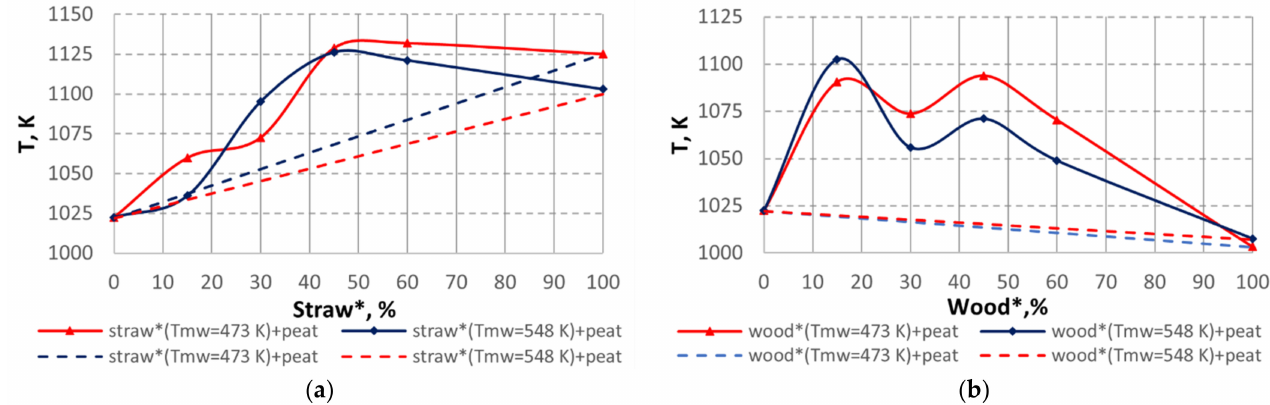
Figure 4. Effect of changes (variations) in pre-treatment temperature and composition of selectively pre-treated wheat straw* ( a ) and wood* ( b ) blends with raw peat pellets on the average values of the flame